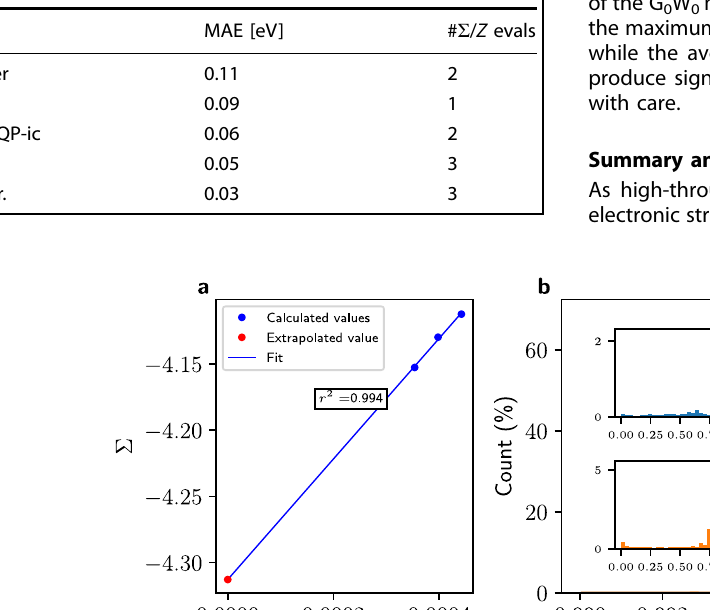
Table 2. Comparison of different methods mean absolute errors (MAE) and the number of Σ evaluations for the various methods discussed in the main text.